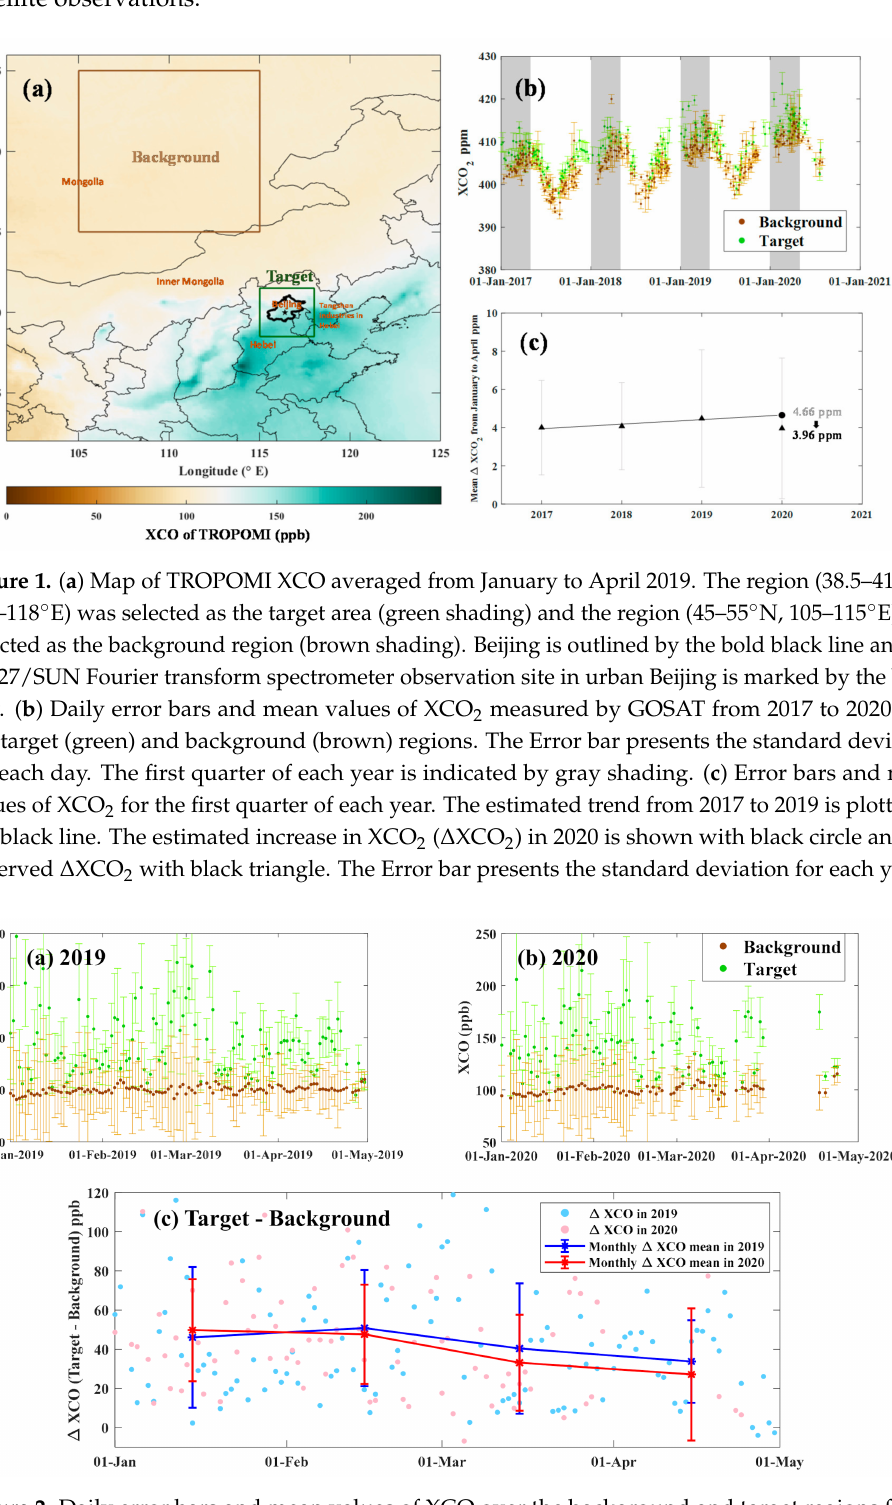
Figure 2. Daily error bars and mean values of XCO over the background and target regions for ( a ) 2019 and ( b ) 2020. Error bar shows the standard deviation of XCO enhancement ( ∆ XCO) for each day in background and target region. ( c ) Daily and monthly increases in XCO ( ∆ XCO) in 2019 (blue) and 2020 (red). Error bar presents the monthly standard deviation of ∆ XCO in 2019 and